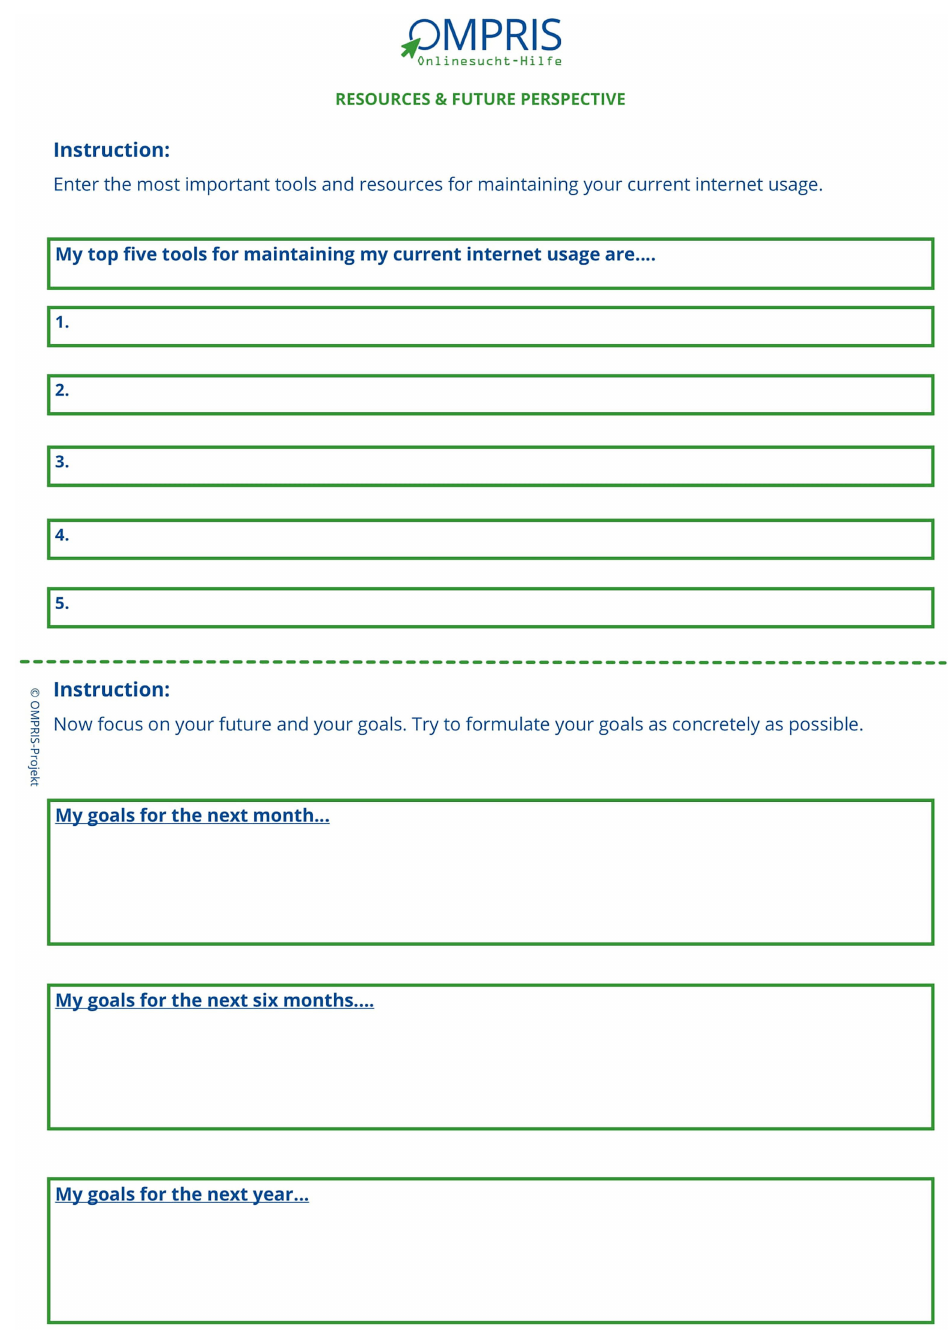
FIGURE 2 Tools and future